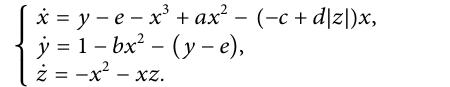
Frontiers in Physics |